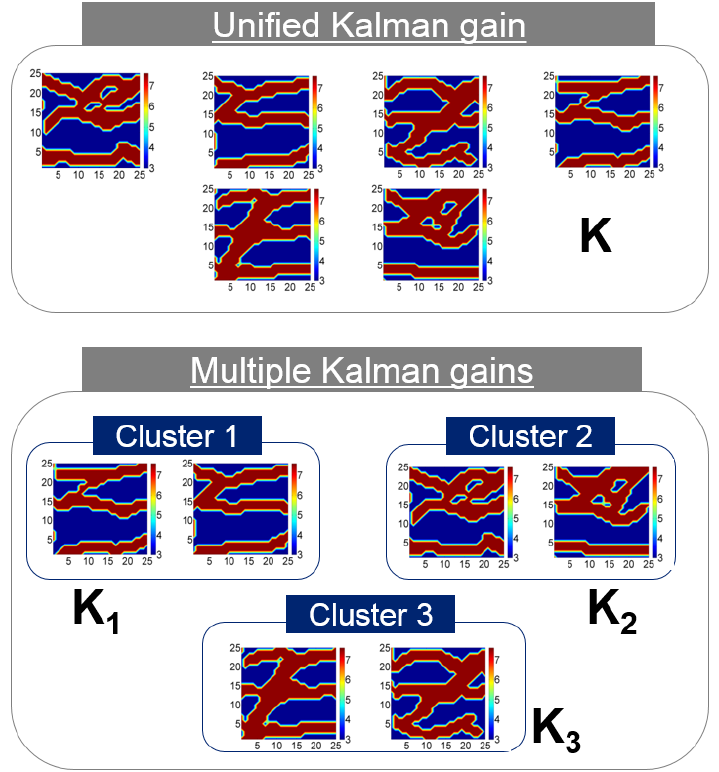
Figure 5. The concept of multiple Kalman gains. The geological scenarios could be separated by clustering.